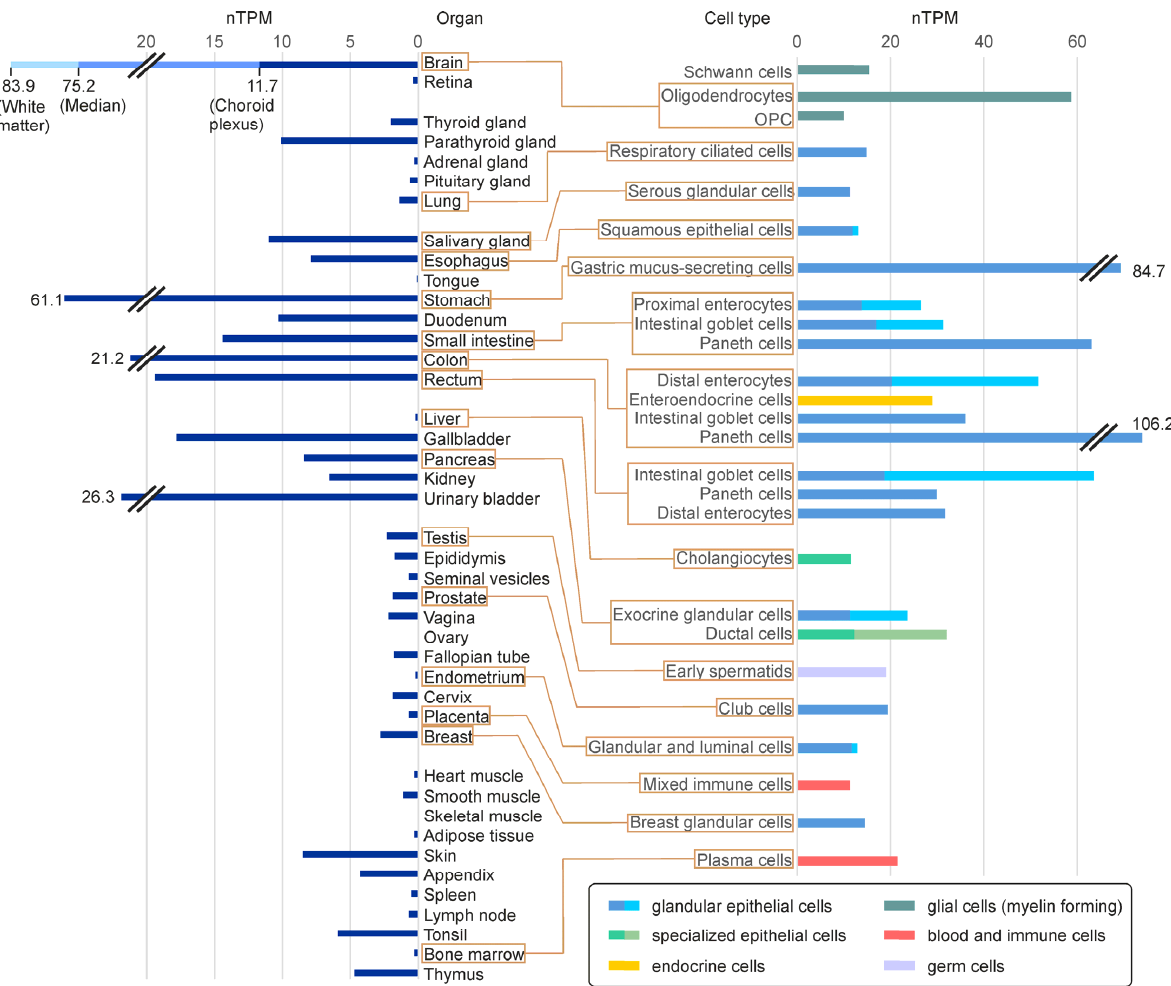
Figure 4. FA2H expression levels in human organs and selected cell types with high FA2H expression levels. Bars indicate the mean normalized expression (TPM = transcripts per million) derived from RNA sequencing data that are accessible via the Human Protein Atlas (https://www.proteinatlas.org/; accessed on 14 February 2023) [80]. For the brain, only the median expression over all brain regions and the maximal (found in white matter) and minimal (in choroid plexus) expression levels are shown. Expression levels in individual cell types were taken from the Human Protein At- las datasets of single-cell type transcriptomes [81]. Only cell types with a normalized expression level > 10 nTPM are displayed. For cell types where several expression levels were reported in the data base, the range is depicted (dark bar = lowest; light bar = highest expression level). Abbreviation: OPC—oligodendrocyte progenitor